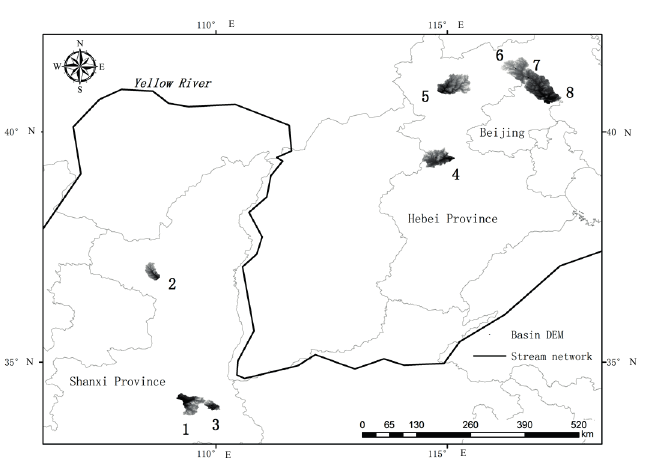
Fig. 1 Locations of the study sites.